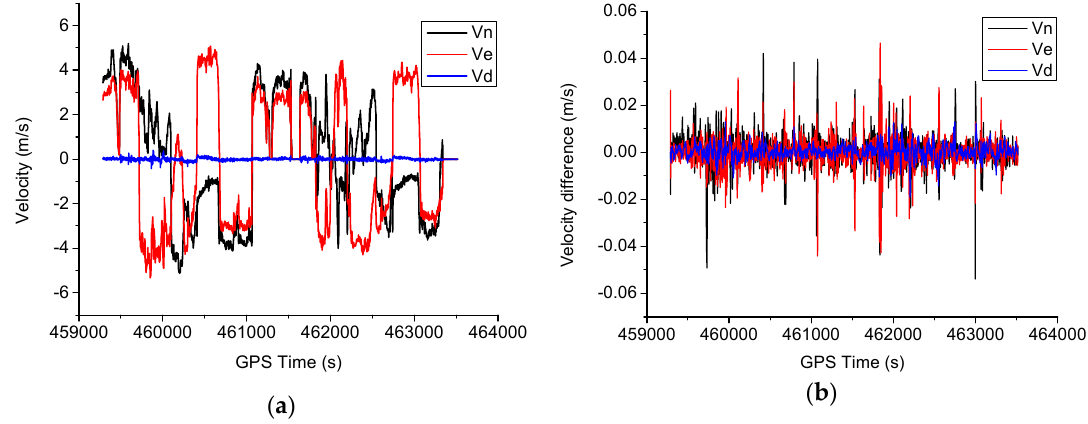
Figure 13. Velocity estimates and difference for the test. ( a ) Velocity estimates; ( b ) Velocity difference.